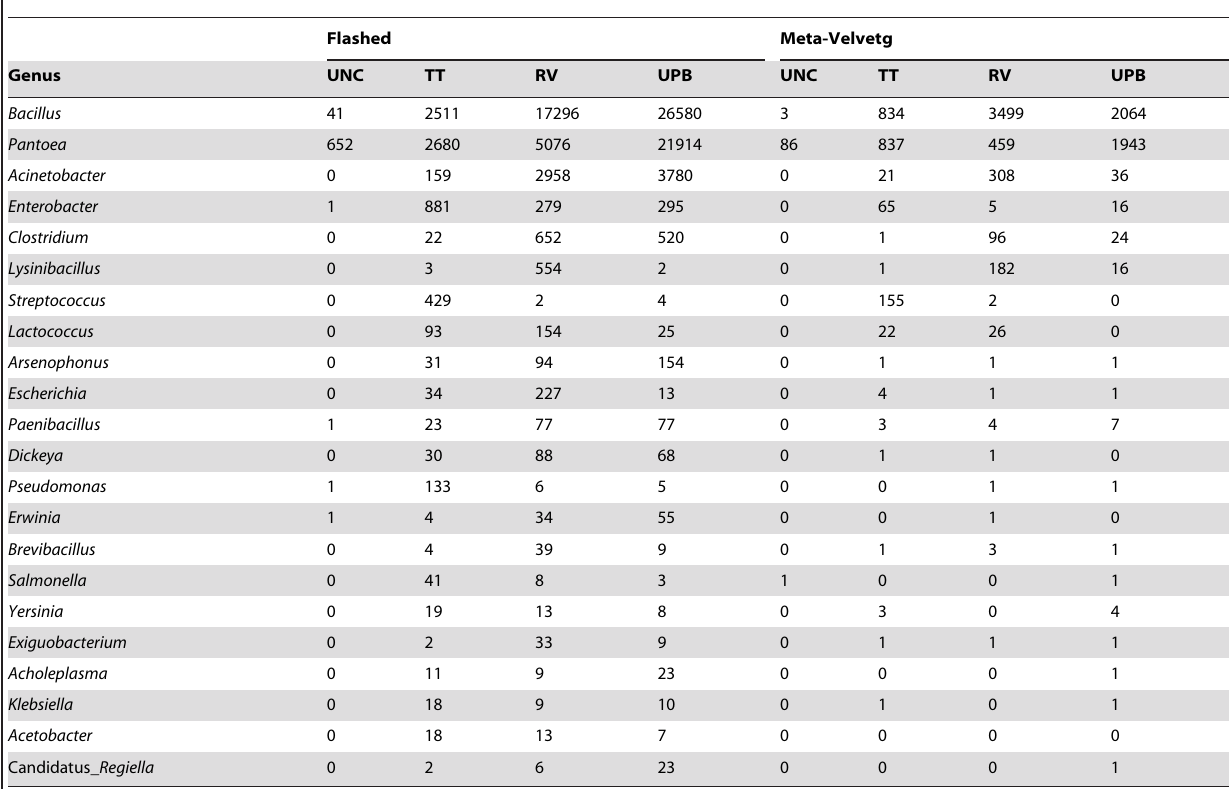
Table 2. Number of reads classified based on a lowest common ancestor approach to bacterial genera across the samples and different assembly